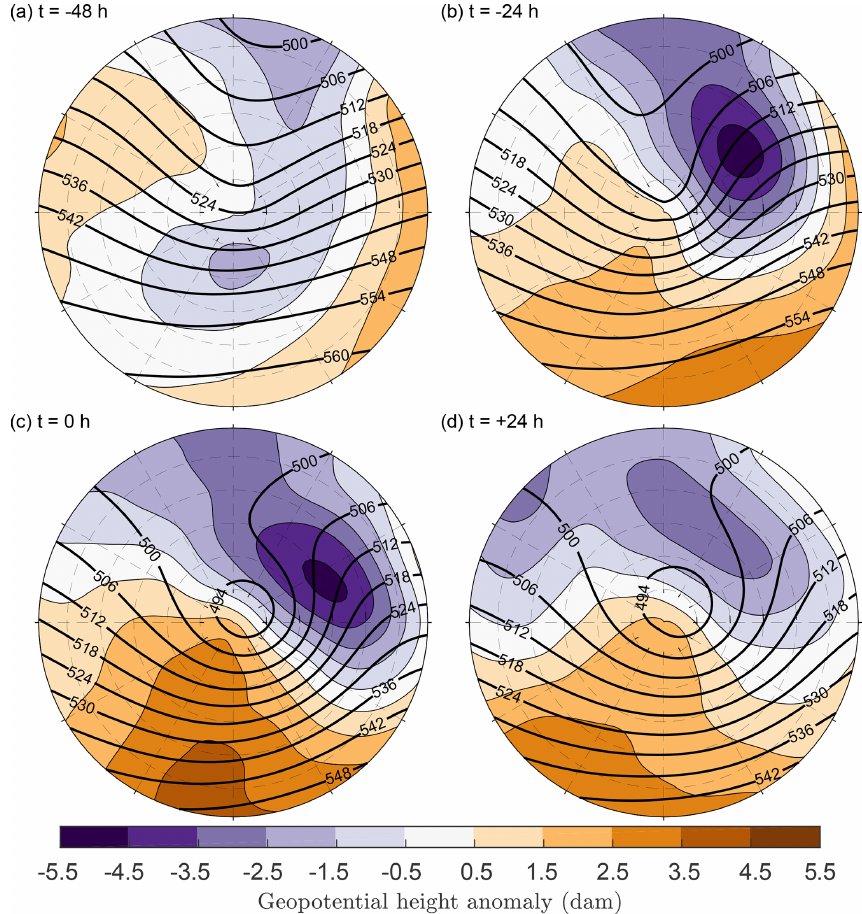
Figure 12. Composite mean of 500hPa geopotential height (dam) in CNTL (black contours) and the difference (SST4 − CNTL) in the cyclone relative anomalies at (a) 48h before time of maximum intensity, (b) 24h before time of maximum intensity, (c) time of maximum intensity, and (d) 24h after the time of maximum